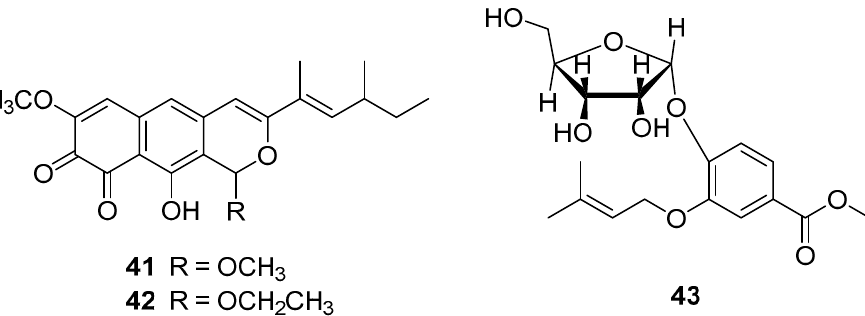
Figure 9. Chemical structures of selected compounds isolated from Laccaria amethystea.